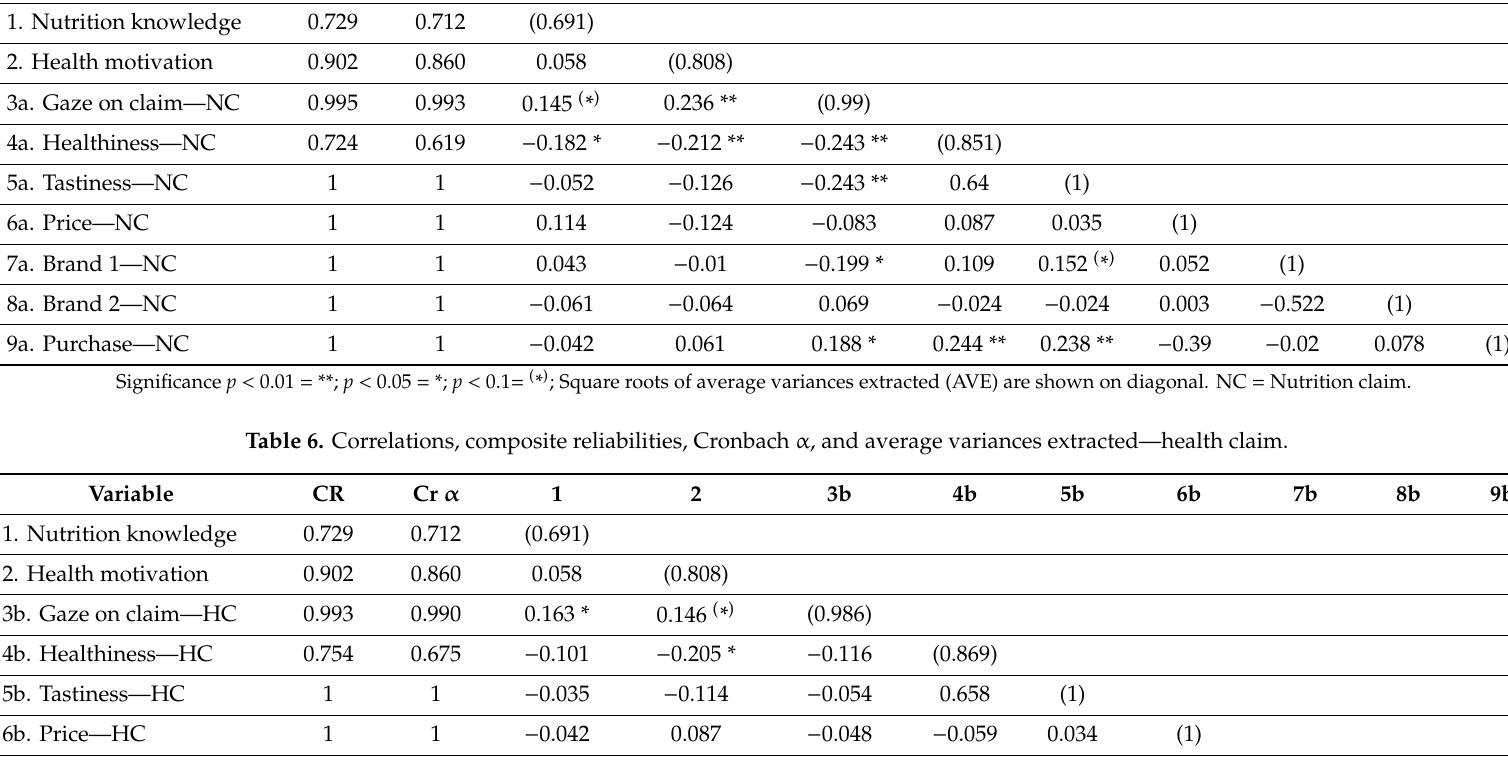
Table 5. Correlations, composite reliabilities, Cronbach α , and average variances extracted—nutrition claim. Variable